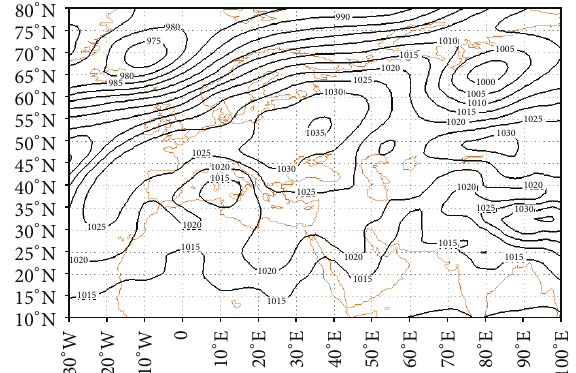
Figure 31: Sea level pressure map in representative day of pattern C.